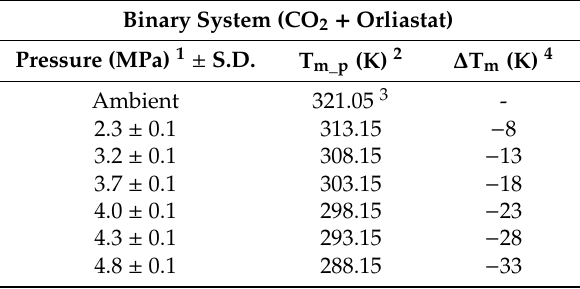
Table 2. Melting point depression of orlistat in a binary system with CO 2 observed by solid–liquid (S-L) phase behavior experiment ( n =